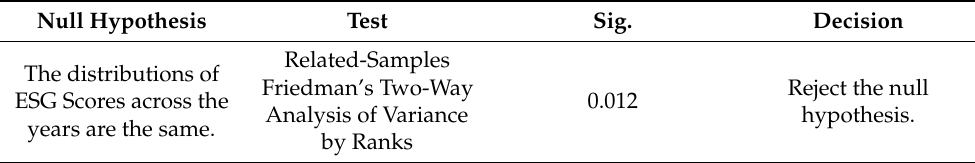
Table 6. Friedman test (distribution of ESG score across years).